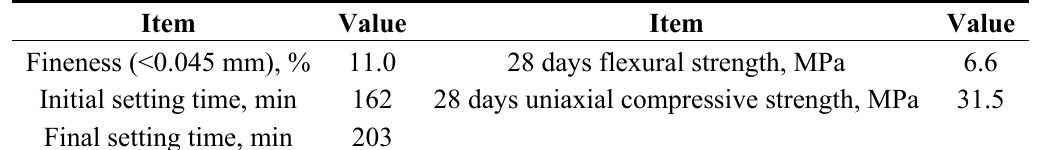
Table 3. Main physical properties of Portland cement (PC I).